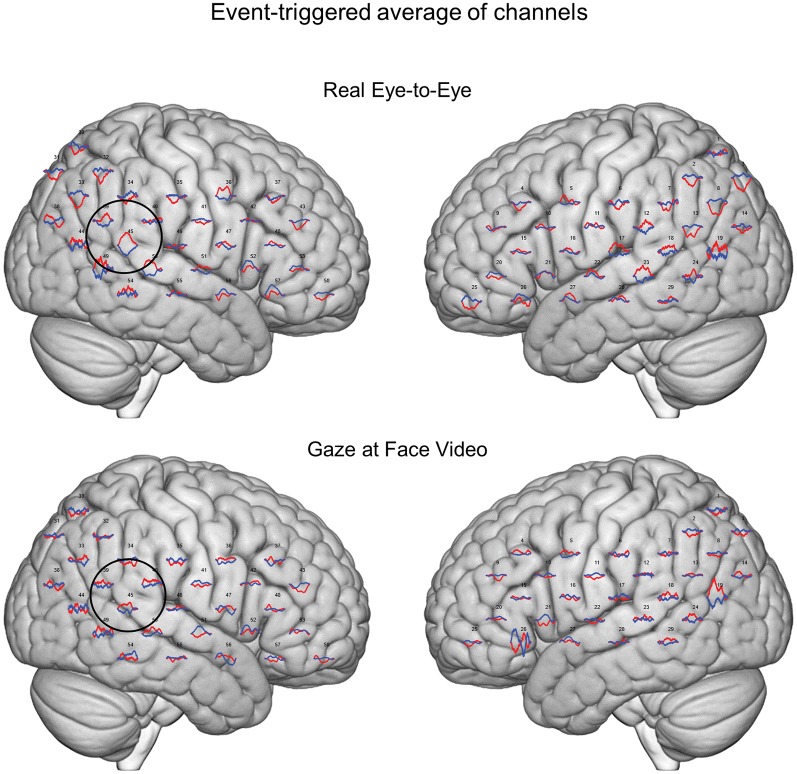
Event-triggered responses. Brain renders indicate event-triggered averaged eye-to-eye responses (top) compared to gaze at face video responses (bottom). Red traces represent group averaged OxyHb responses and blue traces represent deOxyHb responses. The circle represents a diagrammatic representation of the TPJ region of interest for the OxyHb signal (top) and deOxyHb (bottom) signal.